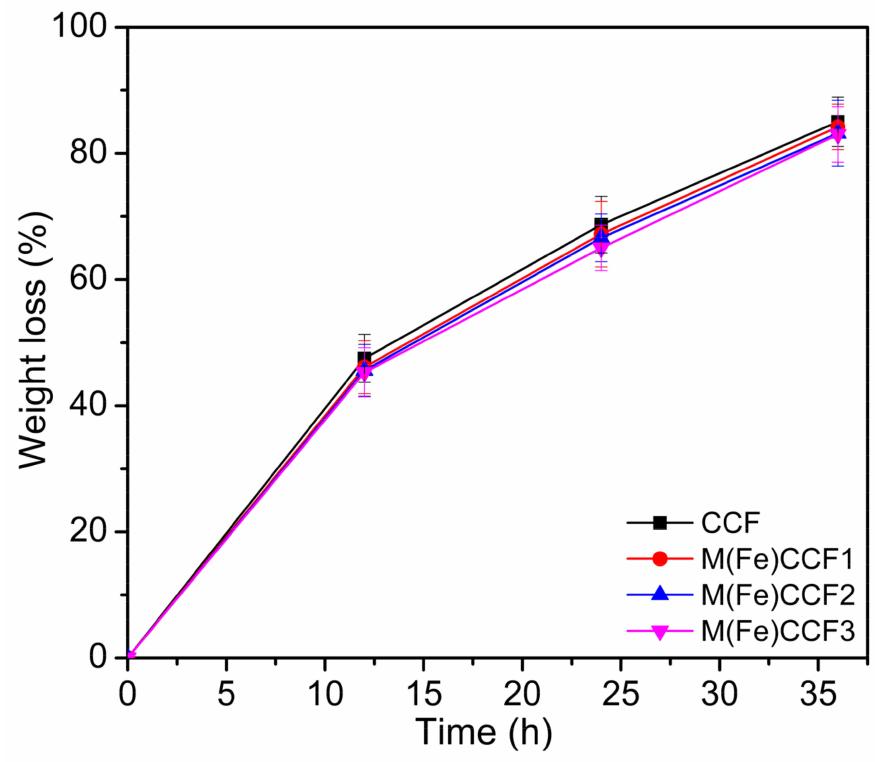
Figure 12. Biodegradation of the CCF and M(Fe)CCFs by the cellulase